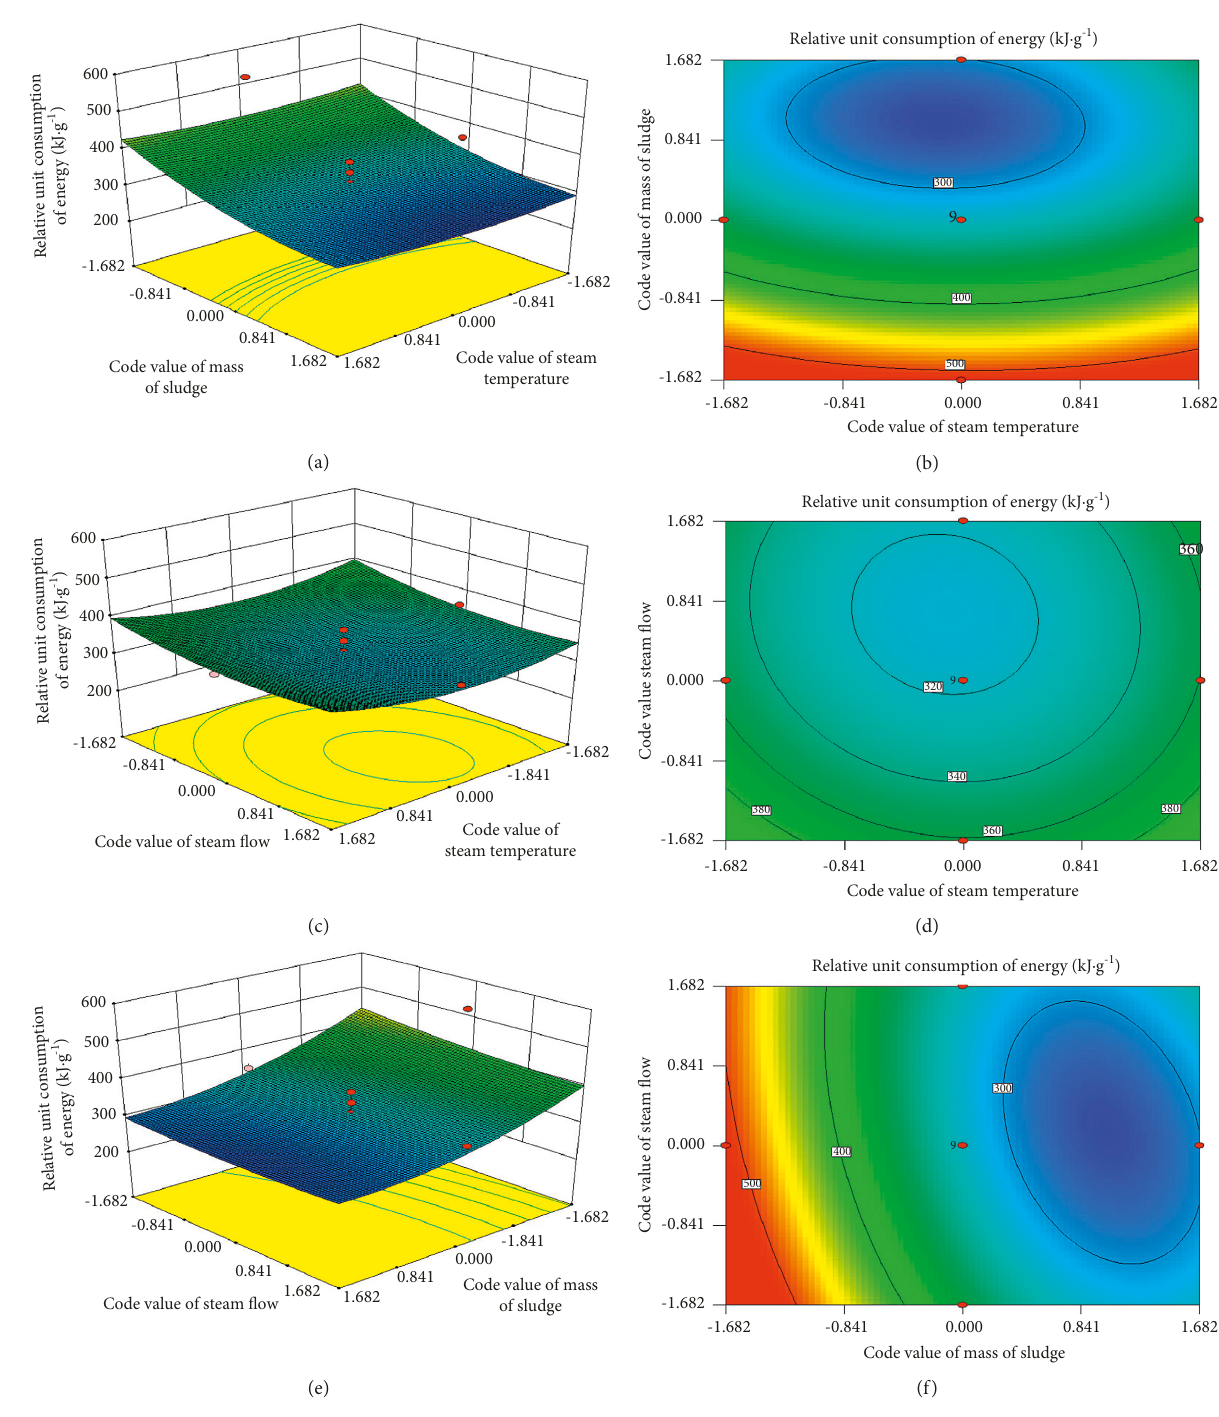
Figure 8: Effects of relative unit energy consumption on mass of sludge temperature, steam flow, and mass of sludge. (a) Response surface plot and contour map of relative energy consumption on steam temperature and mass of sludge. Note: steam flow is fixed at 0 level. (b) Response surface plot and contour map of relative energy consumption on steam temperature and steam flow. Note: mass of sludge is fixed at 0 level. (c) Response surface plot and contour map of relative energy consumption on mass of sludge and steam flow. Note: steam temperature is fixed at 0